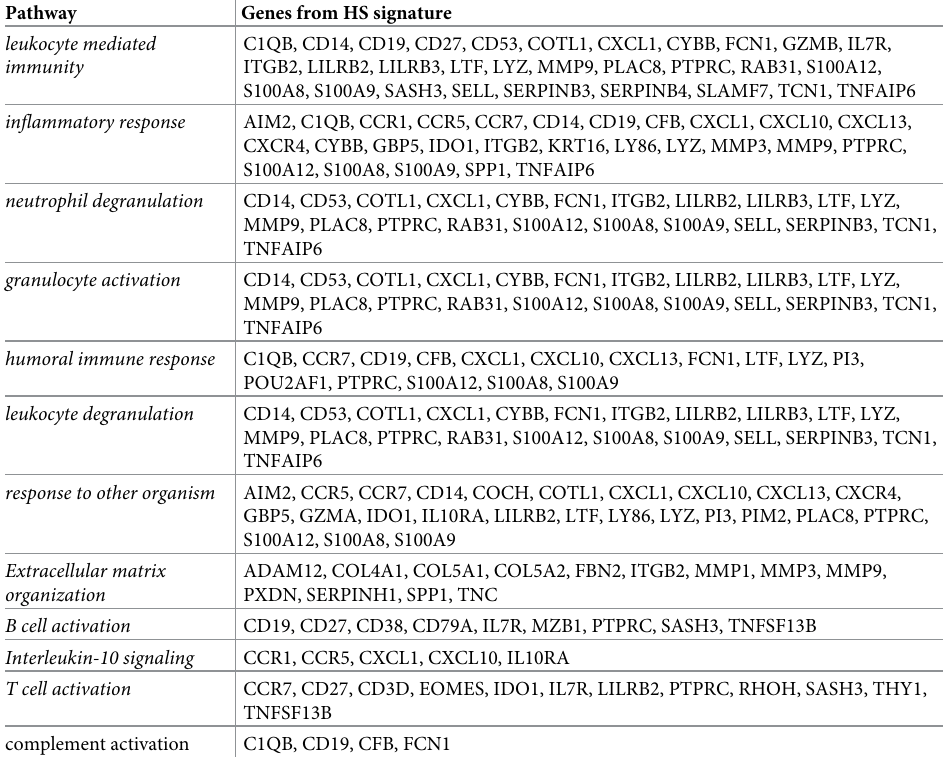
Table 2. Molecular pathways enriched in HS disease signature derived by re-analysis of existing transcriptomic data sets.